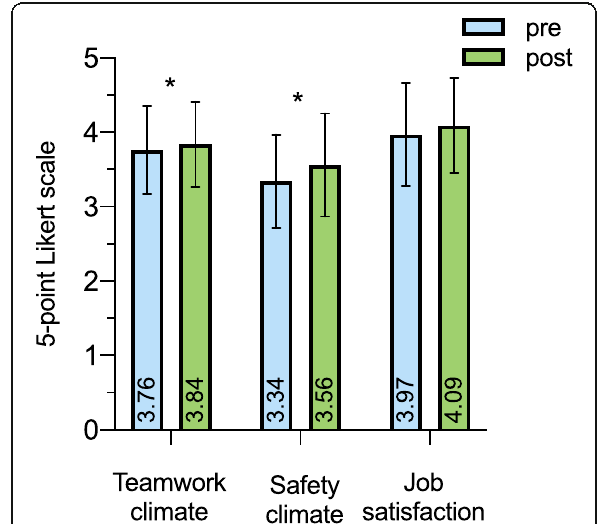
Fig. 1 Influence of simulation-based study intervention on patient safety climate. Mean values and standard deviation (SD) are depicted for each SAQ factor before (pre) and after (post) STREAM study intervention. Individual mean values are written vertical per column. The red lines reflect the proposed benchmark of 3.4 points. * significant difference regarding post hoc analysis p<.05